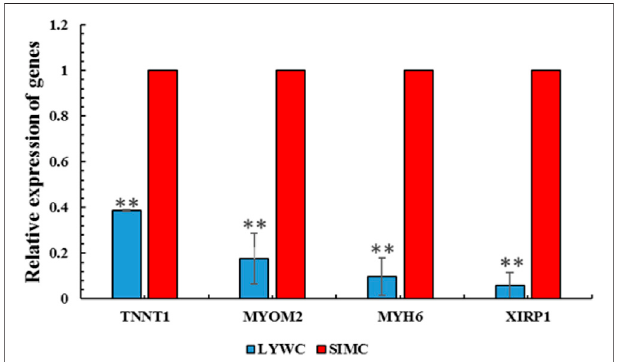
FIGURE7| QPCRresultsoffourdifferentm6A-modi fi edgenesinLYWC and SIMC.